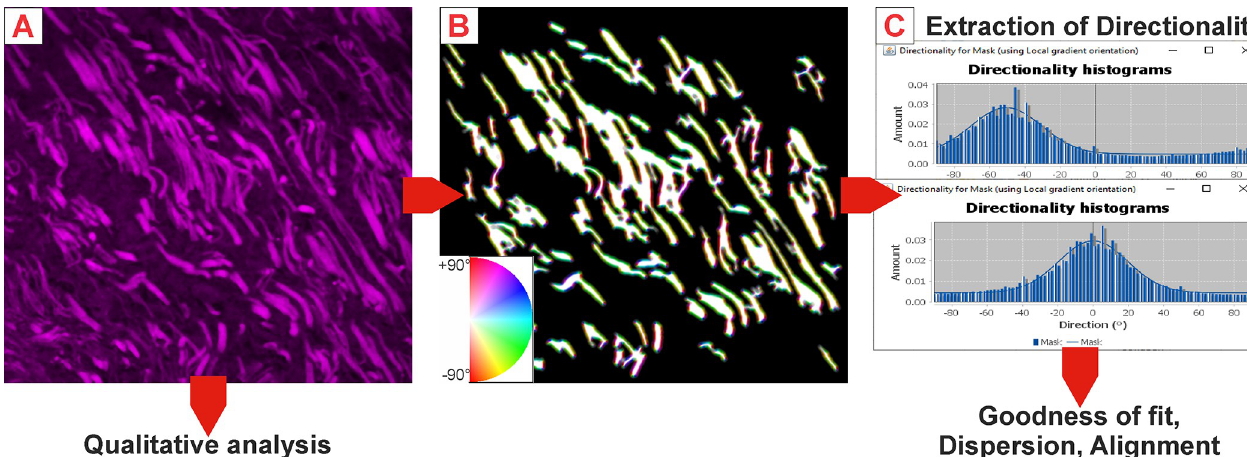
Fig 3. Brief illustration of image fiber analysis covering (A) qualitative analysis based on raw images, (B) computation of a mask, mean filtering and directionality detection with color-coded pixel orientations and (C) normal distribution fits and parameter extraction.